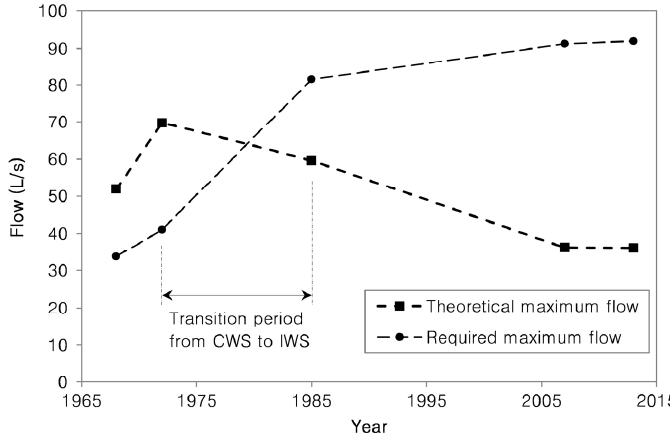
Figure 9. Development of the theoretical maximum flow and the required maximum flow in the study area.